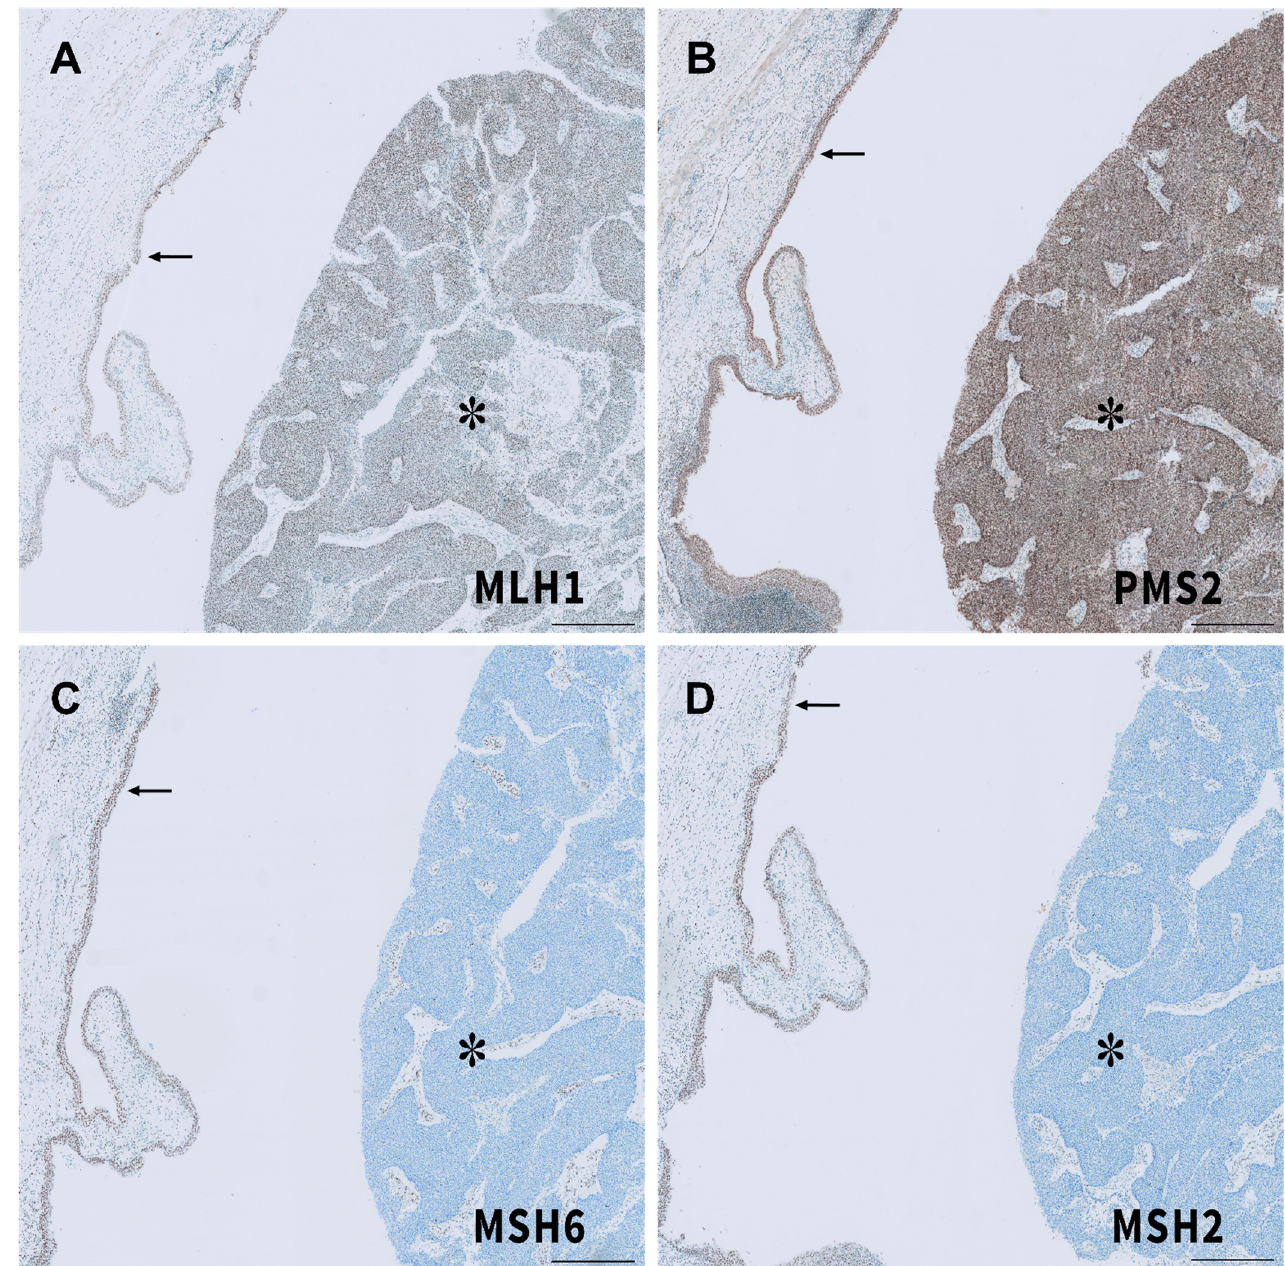
Figure 6. Immunohistochemical analysis of the mismatch repair protein complexes in the radical cystectomy specimen: Urothelial mucosa staining positive for MLH1 , PMS2 , MSH6 , and MSH2 (arrow in ( A – D )) versus lost expression of MSH6 ( C ) and MSH2 ( D ) in the urothelial carcinoma (asterisk).